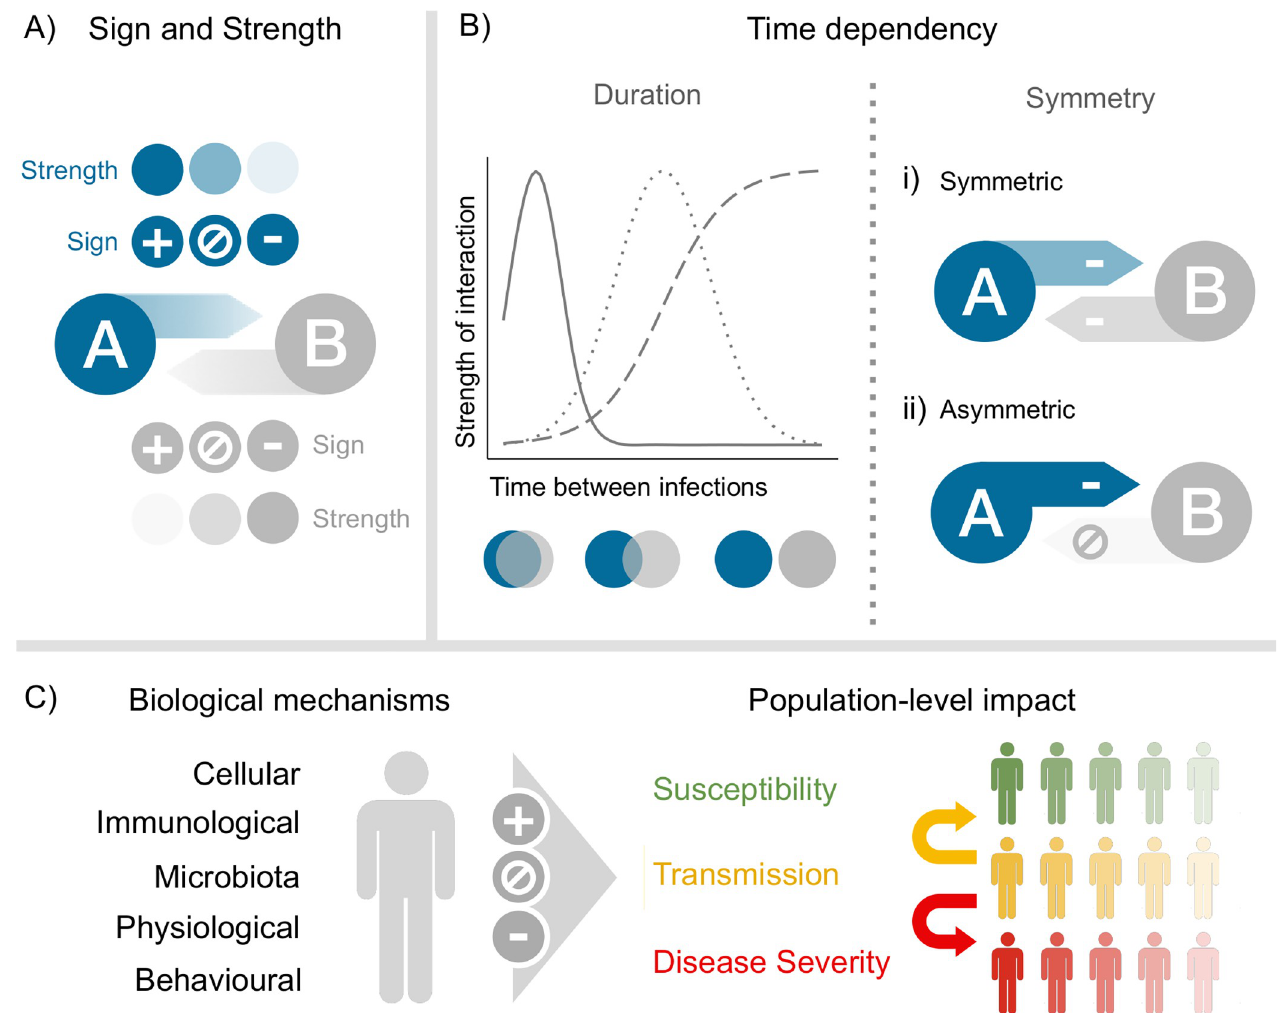
Fig 1. A conceptual framework to study pathogen interactions. For a given pair of pathogens, interaction can be characterized by its sign and strength (panel A), which, in turn, depend on the time interval between infections (duration of interaction) and on the sequence of infection (symmetry of interaction) (panel B). Examples include negative, symmetric interactions (as in the case of influenza B virus Victoria lineage and Yamagata lineage [15]) and negative, asymmetric interactions (as in the case of rhinovirus and influenza A virus or respiratory syncytial virus [18]). Interaction can be caused by different biological mechanisms (panel C), which determine its positive or negative effects on susceptibility to infection, transmission (transmissibility and duration of infection), or disease severity at the individual level and, in turn, its impact at the population